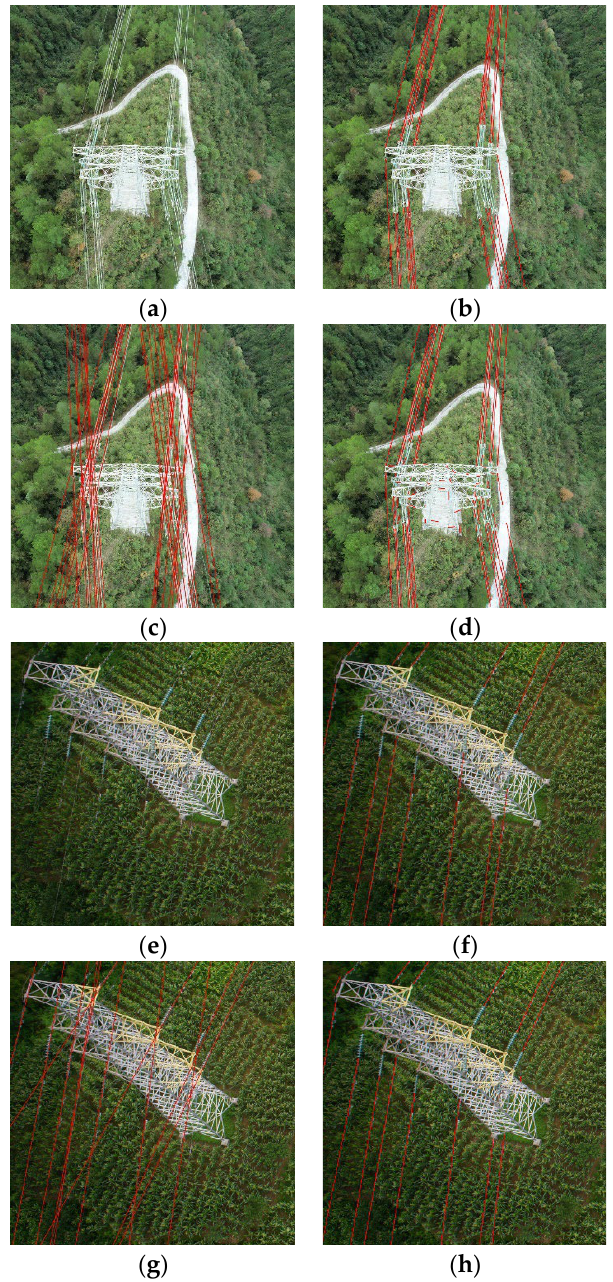
Figure 18. Extraction results for images including power towers: ( a , e ) are the original images; ( b , f ) are the ground truth; ( c , g ) are the results for the CRT method; and ( d , h ) are the final fitting results for the method in this paper.